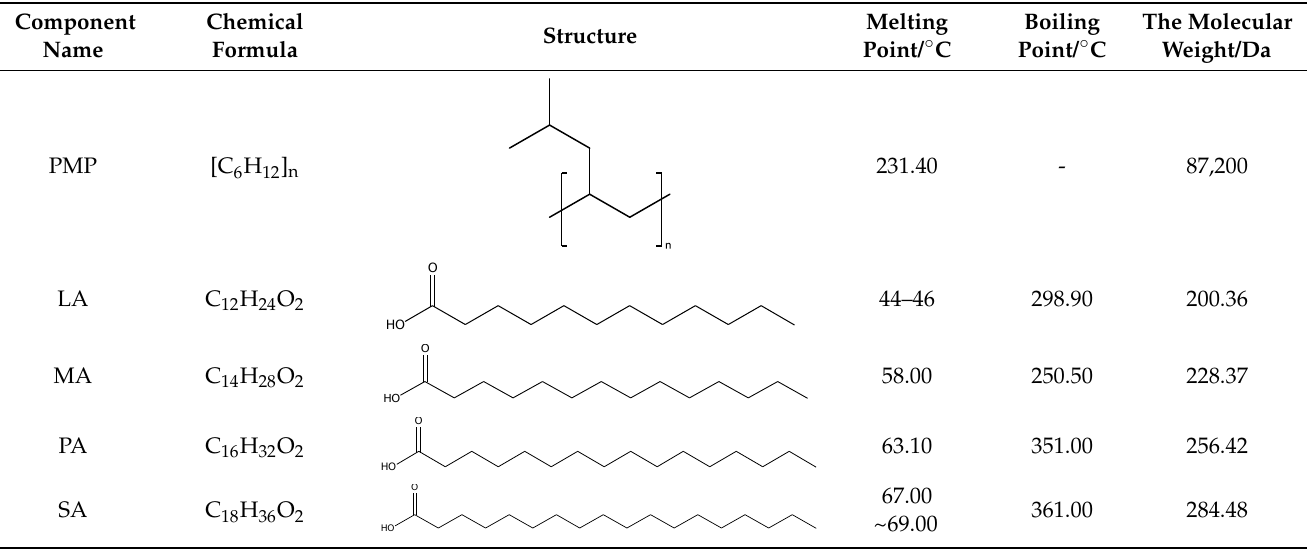
Table 2. The chemical formulas, the molecular structures, and the basic physical properties of the PMP and fatty acids adopted in the work.